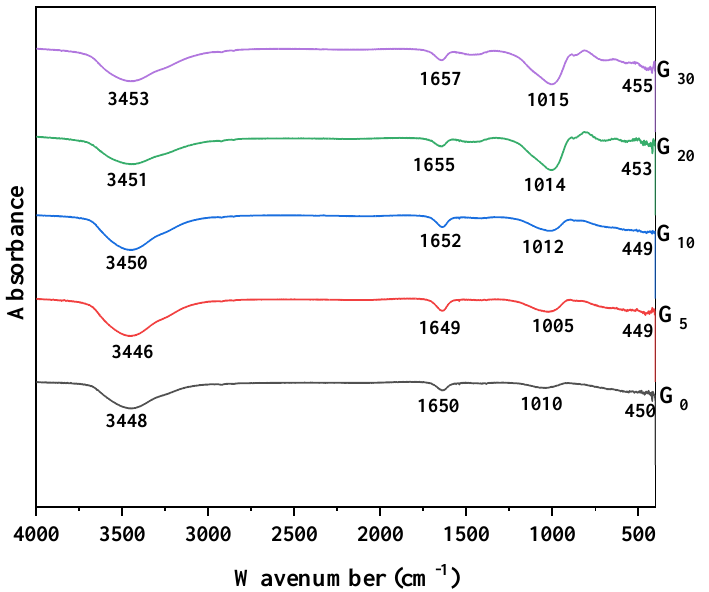
Figure 7. FTIR spectra of geopolymers containing 0% CEM I (G 0 ), 5% CEM I (G 5 ), 10% CEM I (G 10 ), 20% CEM I (G 20 ), and 30% CEM I (G 30 ).